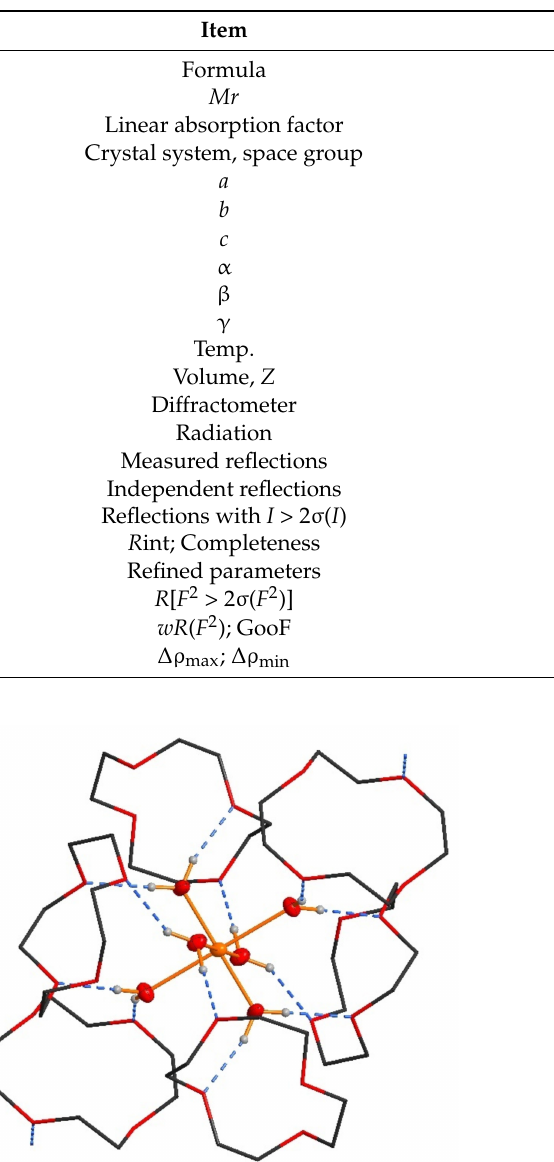
Table 3. Crystal data, data collection and refinement of [Cu(H 2 O) 6 (12-crown-4) 5 ]I 6 · 2I 2 .